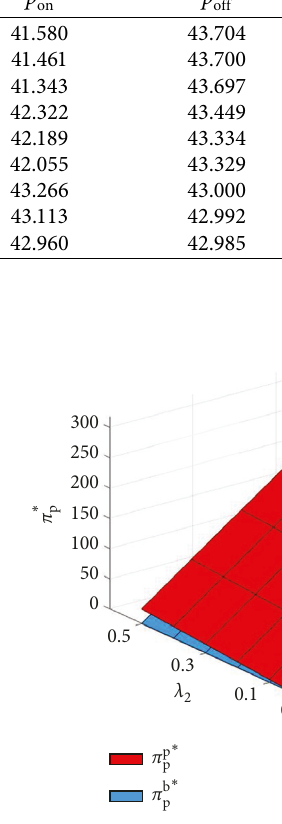
Figure 4: Impact of change in λ profit.